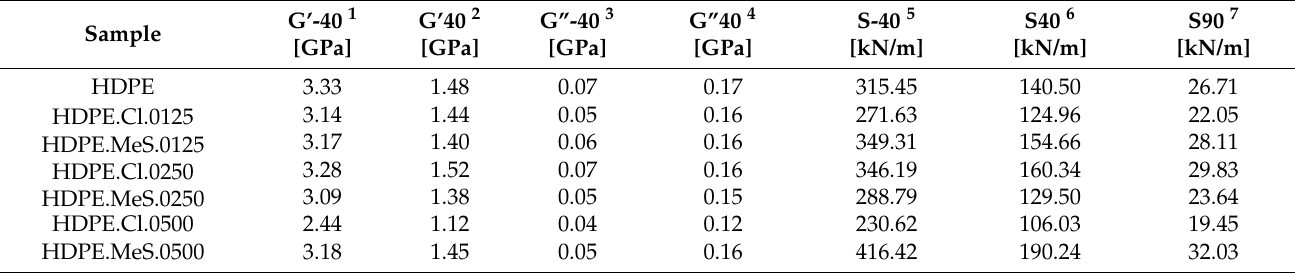
Table 2. Dynamic Mechanical Properties of HDPE